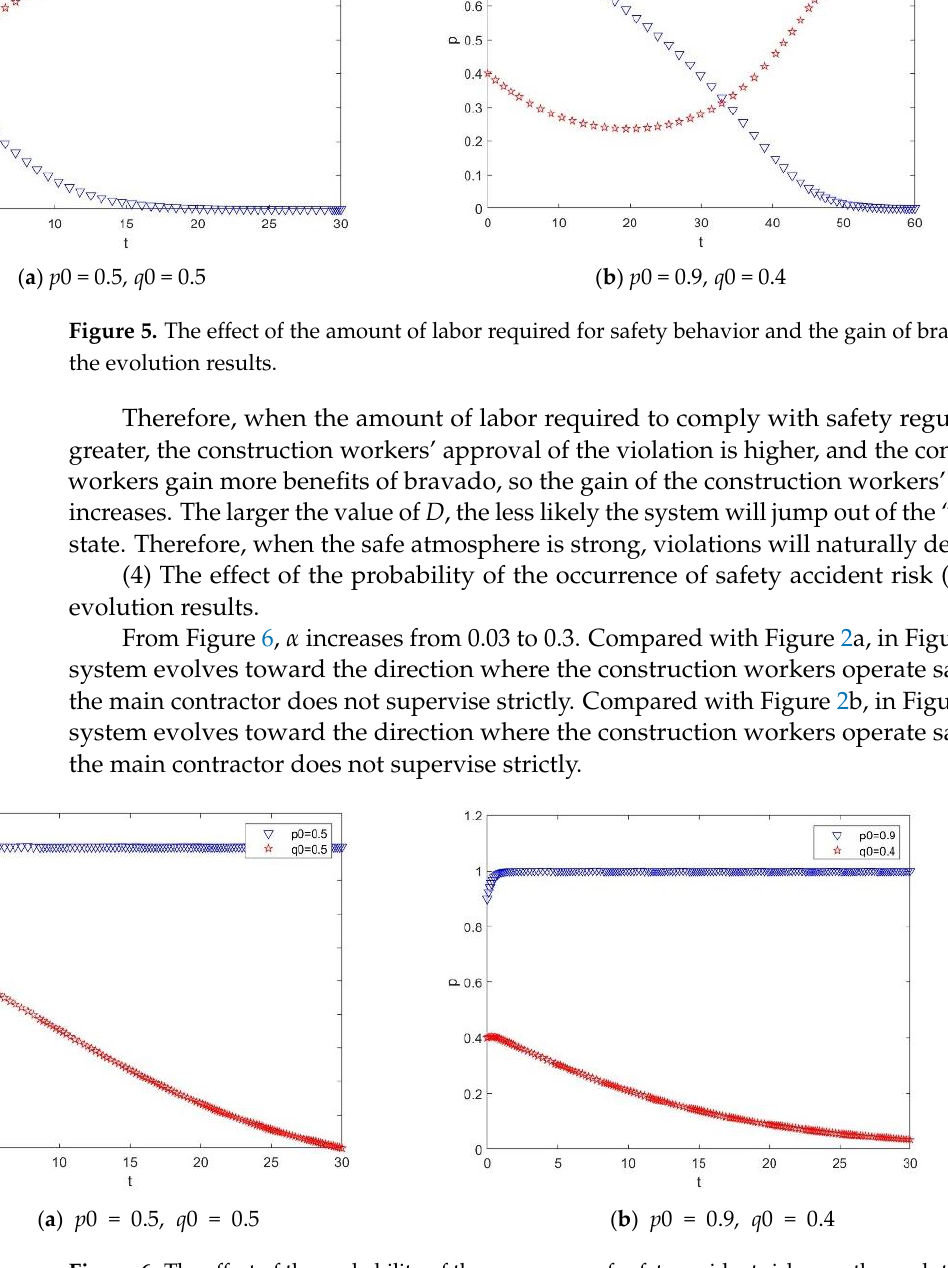
Figure 6. The effect of the probability of the occurrence of safety accident risk α on the evolution